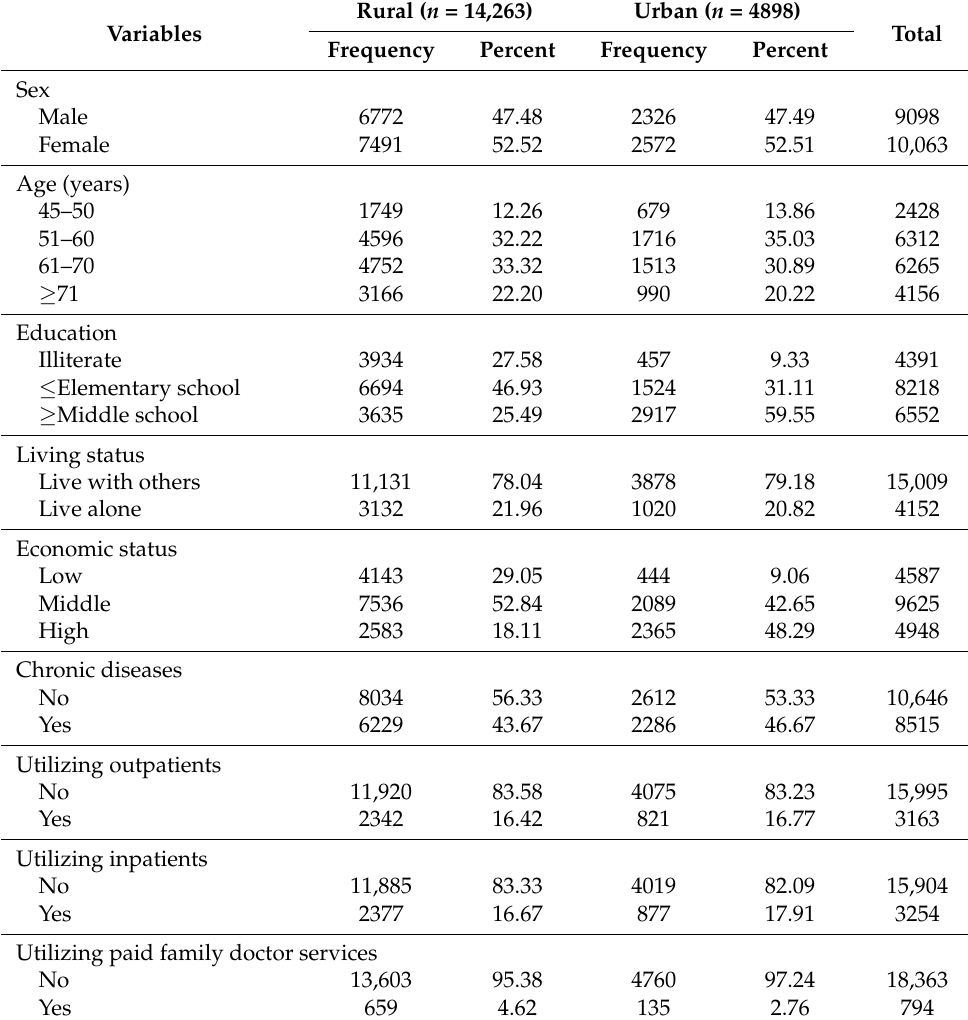
Table 2. Description of characteristics ( n = 19,161).